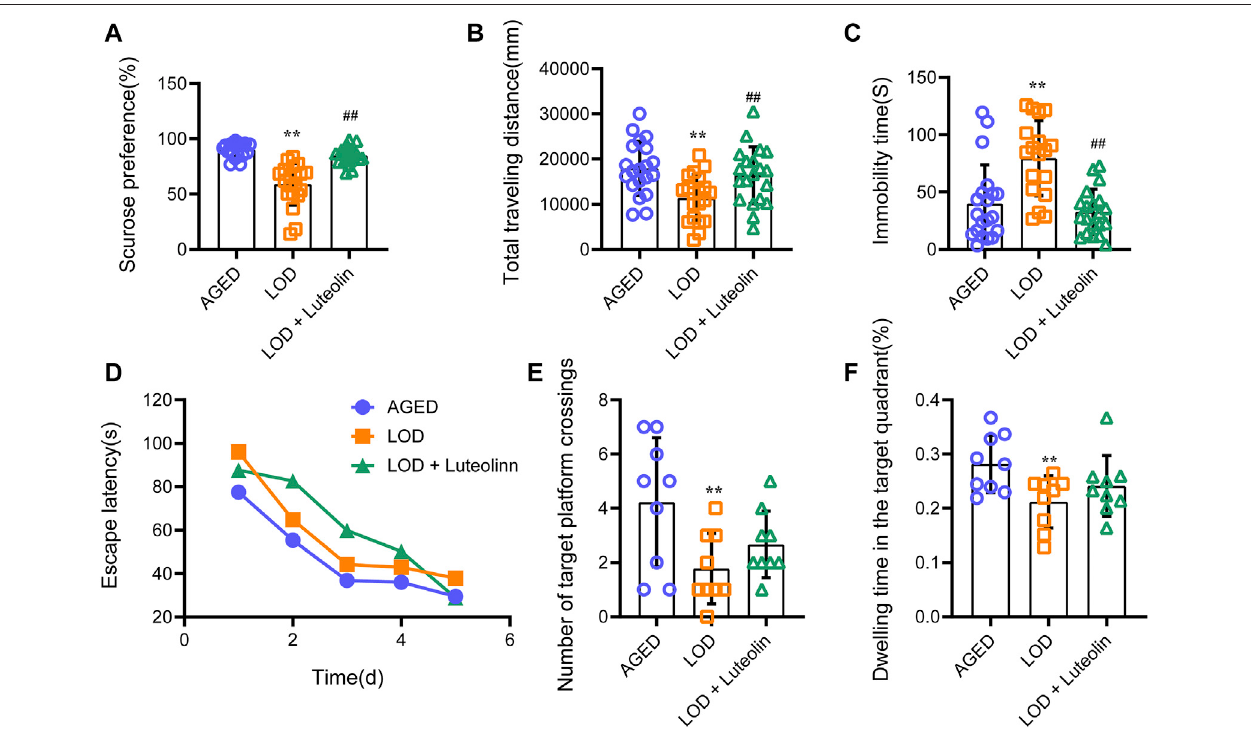
FIGURE2| EffectsofluteolinonthebehaviorofLODrats. (A) ResultsoftheSPT( n =18 – 20); (B) totaldistanceintheopen fi eldtest( n =18 – 20); (C) immobilitytime intheFST( n =18 – 20); (D) EscapelatencyintheMWMtest( n =9); (E) NumberoftargetplatformcrossingintheMWMtest( n =9); (F) Dwellingtimeinthetargetquadrant in the MWM test ( n = 9). SPT results were not consistent with a normal distribution and used non-parametric tests for comparisons. Data consistent with a normal distribution were analyzed using one-way analysis of variance. For pairwise comparisons, the Games-Howell method was used to assess results with heterogenous variance (number of target platform crossings in MWT), and the least signi fi cant difference test was used to assess results with homogenous variance (other results). The MWM escape latency was analyzed by repeated-measures analysis of variance. Data are expressed as the mean ± SEM, * p < 0.05, ** p < 0.01, vs. AGED; # p < 0.05, ## p < 0.01, vs.